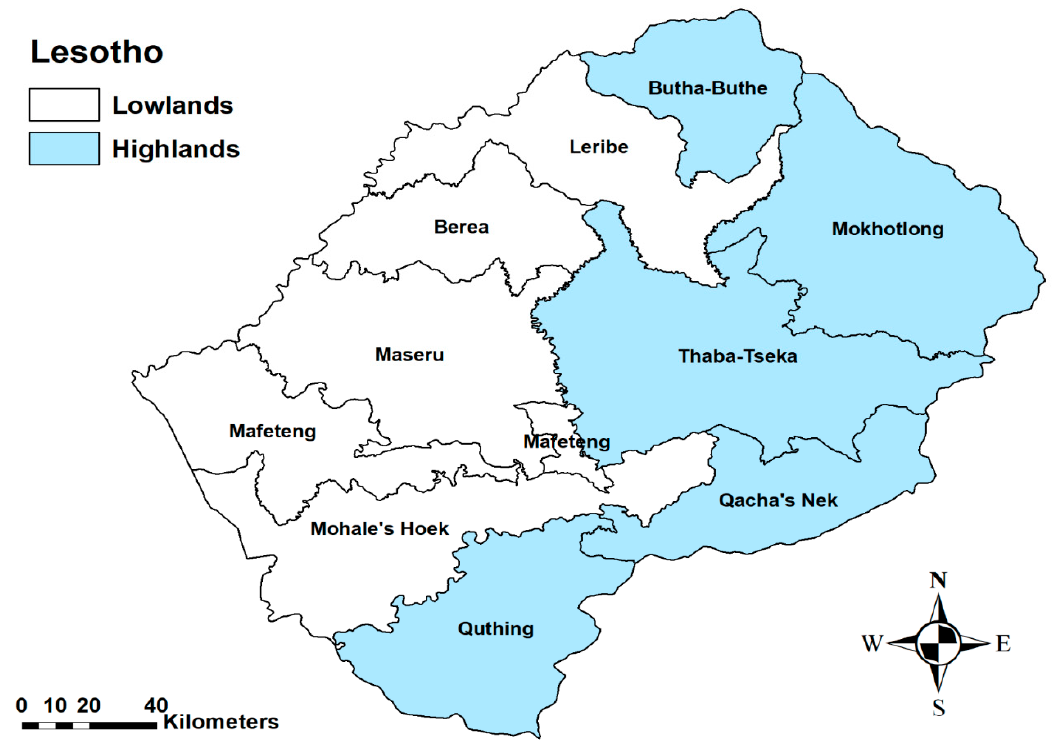
Figure 1. Map showing the ten administrative districts of Lesotho and the two topographical zones [10].